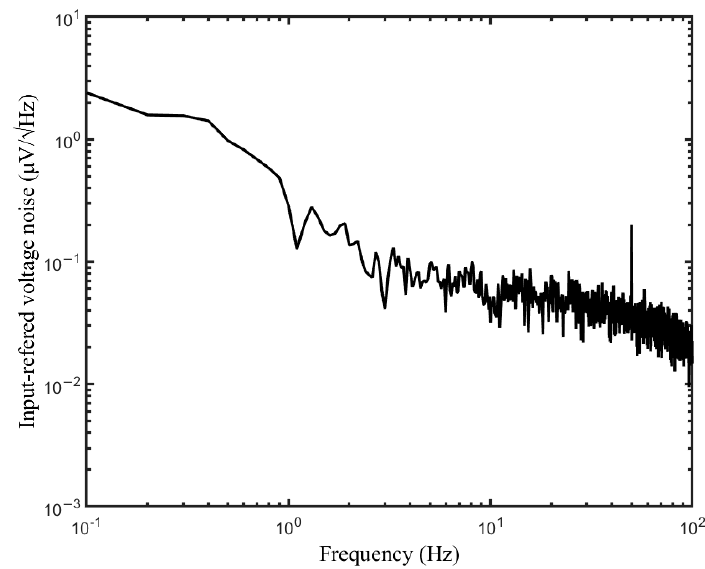
Figure 7. The input ‐ referred voltage noise